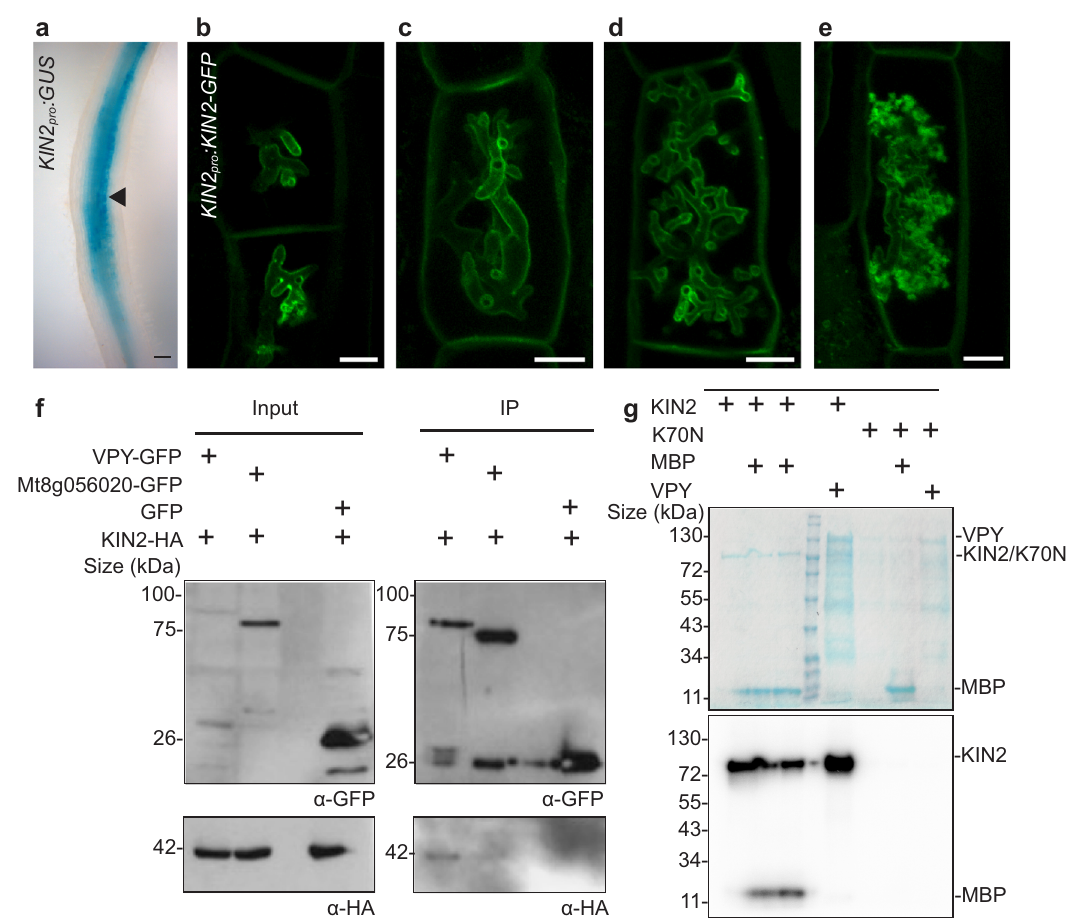
Fig. 7 | VPY interacts withthe PAM-localizedkinase,KINASE2.a Colonized root expressing KIN2pro : GUS . Scale bar, 100 μ m. Representative image, n =5 transgenic root systems and 15 infection units. b – e Cells containing arbuscules from roots expressing KIN2pro:KIN2-GFP . KIN2-GFP locates at the periarbuscular membrane and plasma membranes in cells with arbuscules at all stages of development and degeneration.Scalebarsare10microns.Representativeimageof n =60arbuscule- containing cells. f Co-immunoprecipitation assay with VPY and KIN2. VPY-GFP, or controls, Medtr8g056020-GFP (Mt8g056020-GFP) or GFP were co-expressed in N.